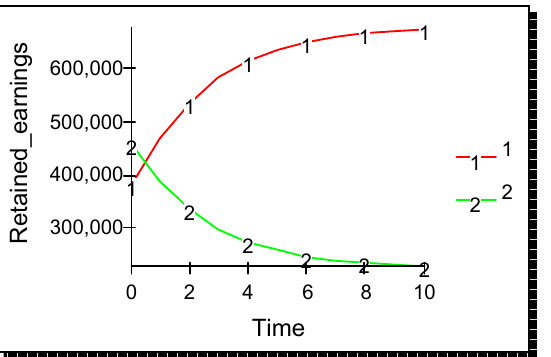
− 10 ; σ − 1.5 × 10 − 10 ; 12 =